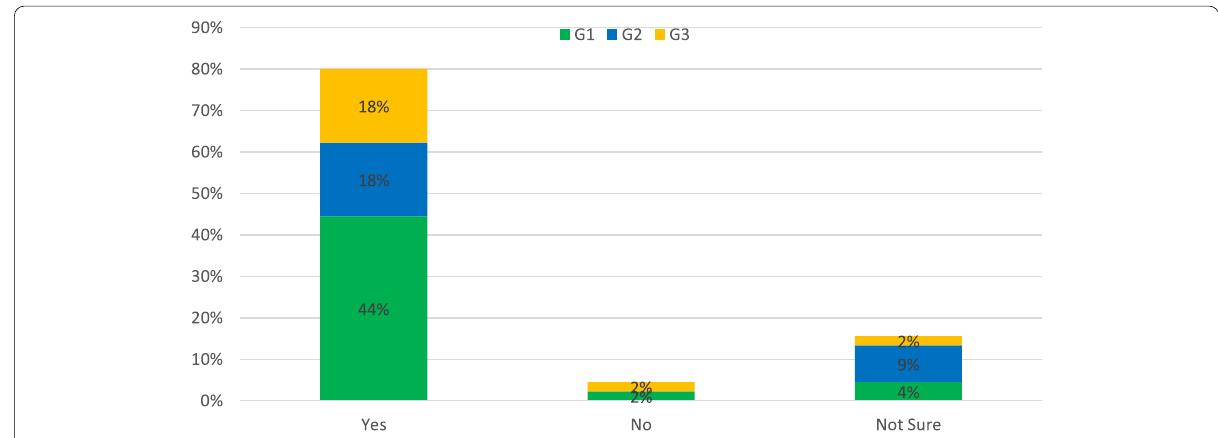
Fig. 9 Response to: Do you believe that there is a need to expand public transport services to eliminate/reduce transport